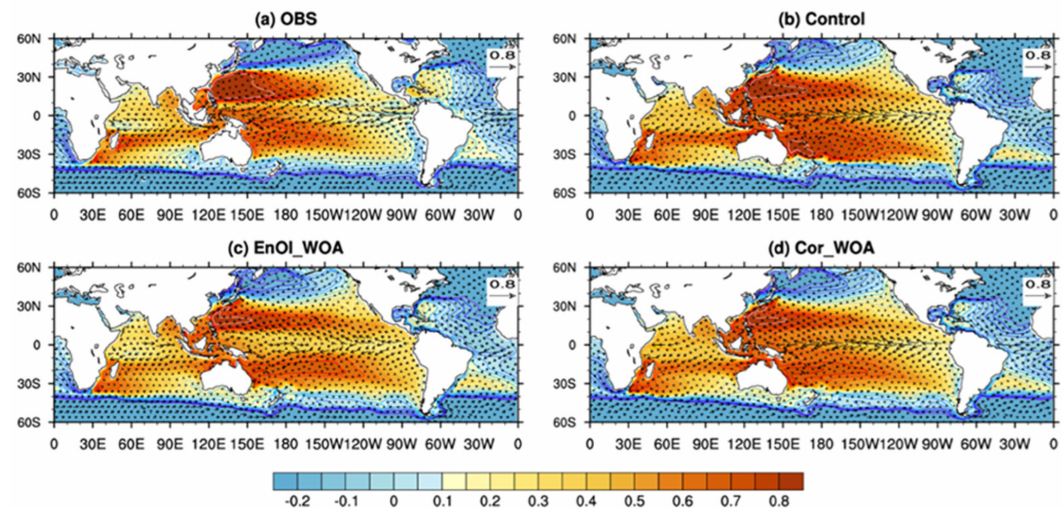
Figure 2. Long-term average horizontal distribution of the global sea surface height (shaded, unit: m) and current field (arrow, unit: m/s). ( a – d ) represent OBS, Control, EnOI_WOA, and